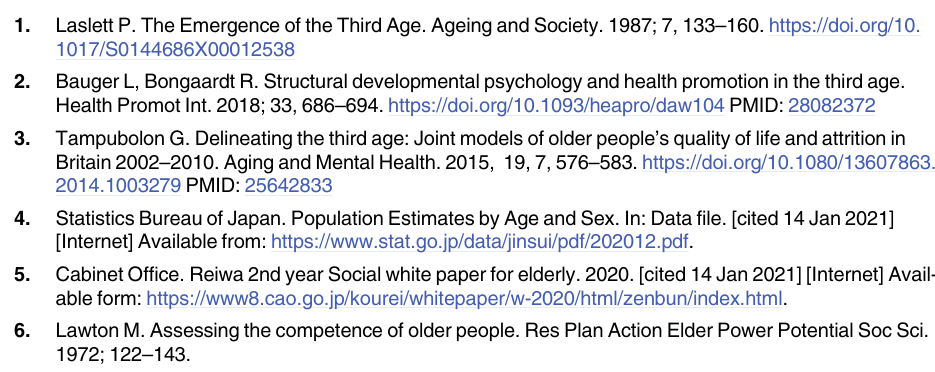
S2 Fig. Appendix. The SET Japanese